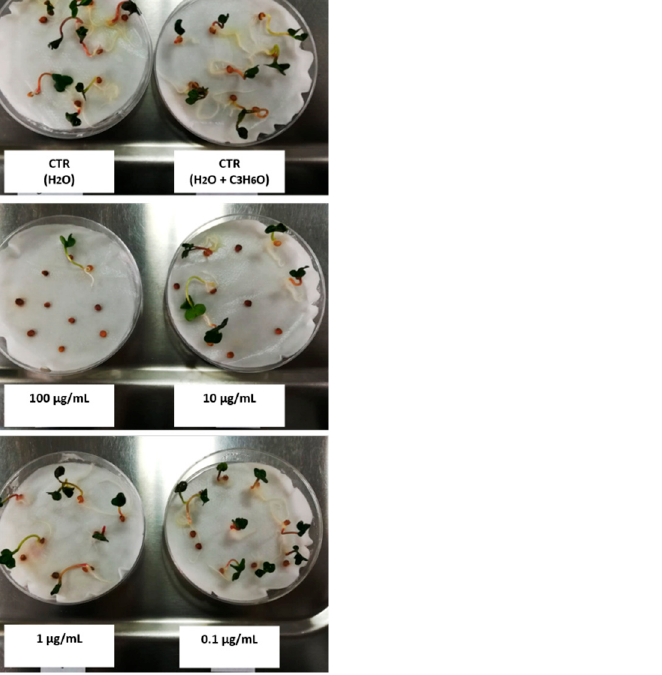
Figure 8. Representative photo of phytotoxic assay carried out on R. sativus seeds.